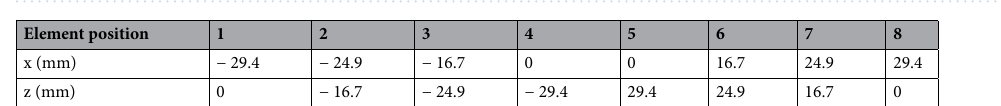
Figure 1. ( a ) Maxwell Fisheye lens based beamformer with transceiver input in first half of the lens, and monopole circular antenna array in the second half of the lens, ( b ) Ray tracing diagram depicting source and image locations in a metallic mirror enclosed Maxwell fisheye lens ( c ) Simulated absolute E -field inside the lens structure when a signal at 10 GHz is excited at the source probe of the lens, ( d ) Comparison between far-field directivity of an ideal semicircular antenna array and the proposed Maxwell fisheye lens based beamformer when relative phase shifting given in Table 2 is applied.